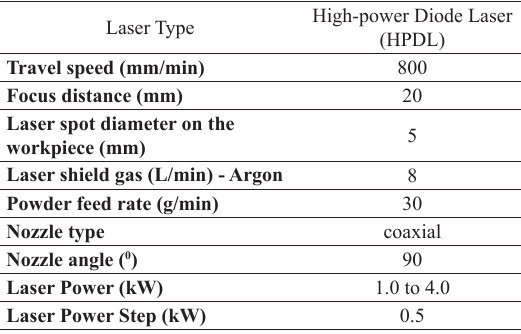
Figure 3. Typical SEM view of the worn track (a) and volume measurement using interferometry Table 2. Summary of laser parameters